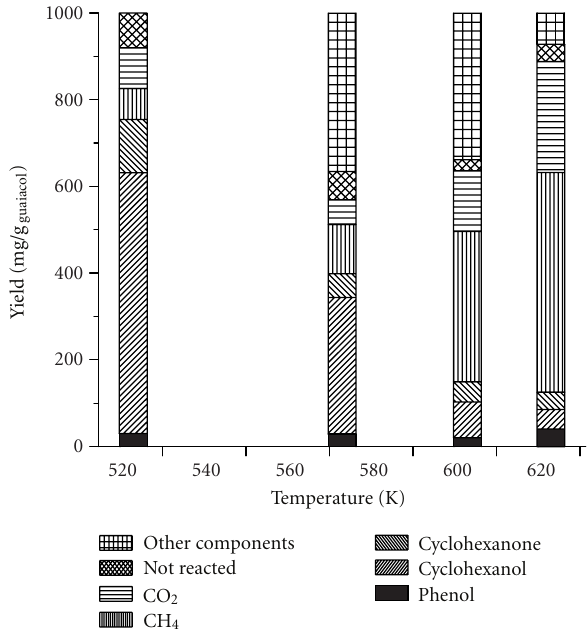
Figure 6: Yield of main products from hydrogenation of 10g/L guaiacol in water with RANEY Nickel and H 2